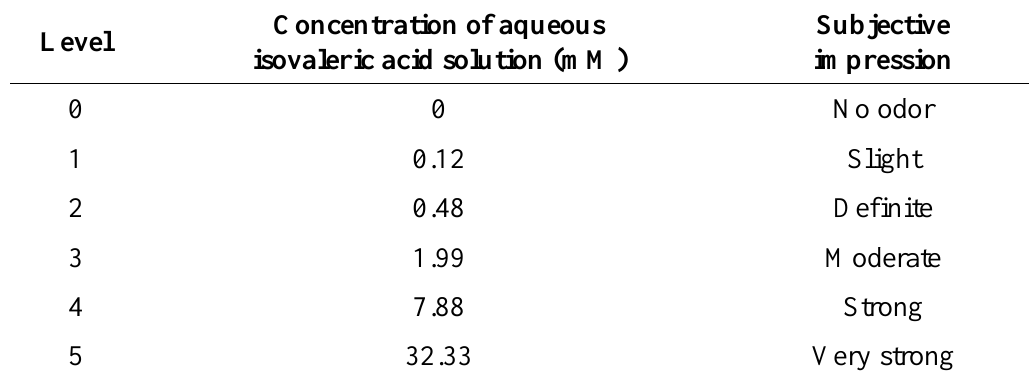
impression by using human